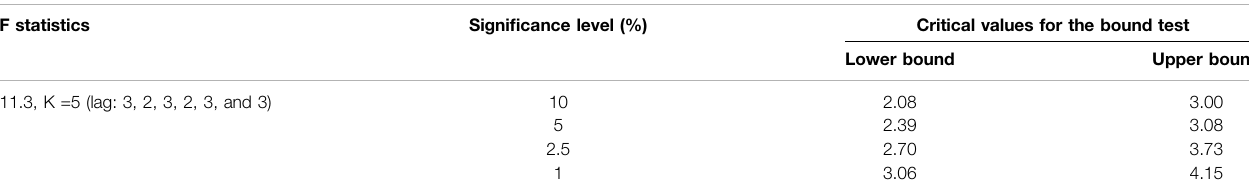
TABLE 6 | Results of ARDL co-integration.